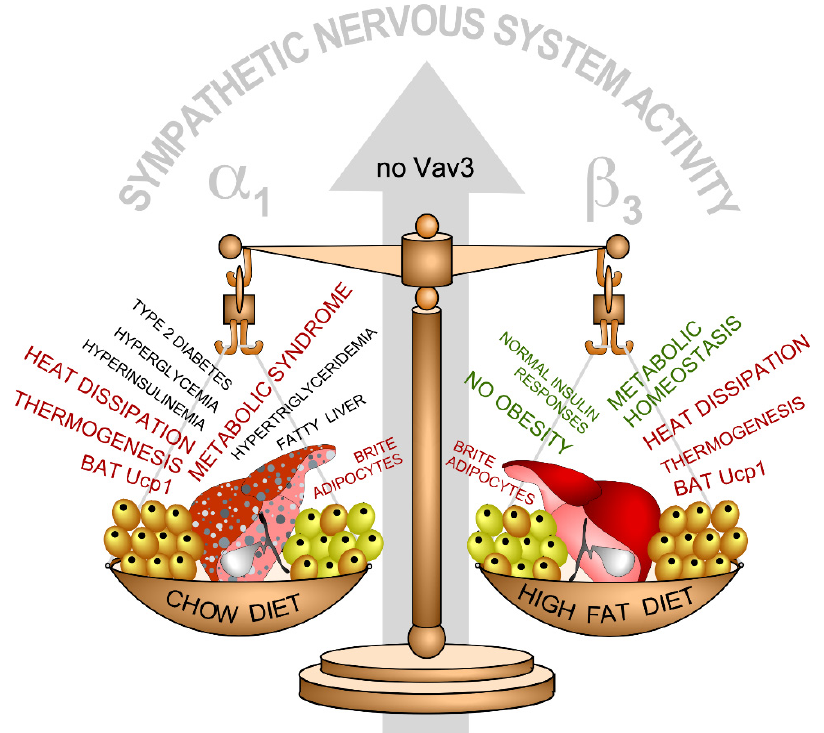
Figure 4. Summary of the physiological and metabolic dysfunctions found in Vav3 –/– mice under chow (left) and high-fat (right) diet conditions in BAT (cells colored in light brown), WAT (cells colored in yellow), liver (red), and plasma. Defects are shown in red and black. Normal responses are shown in green. The main adrenergic receptors involved in the responses found in chow ( α 1 ) and high-fat diet ( β 3 ) conditions are indicated. Further information is in the main text and reference [63] .